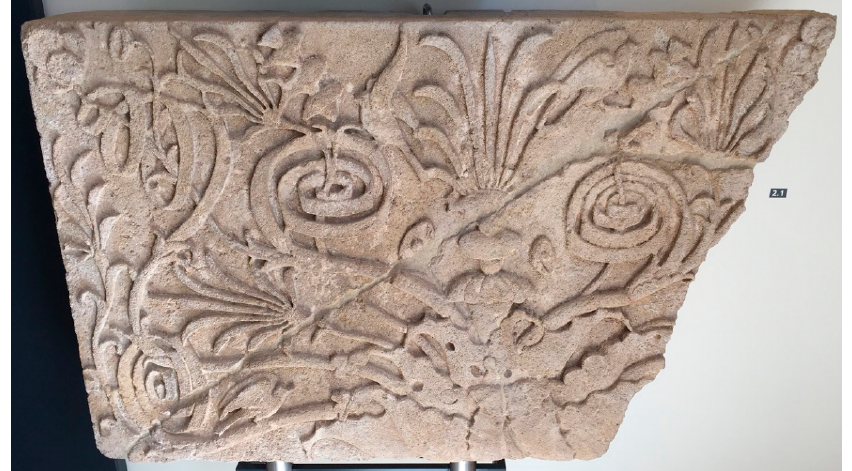
Figure 19. Taranto, Museo Archeologico Nazionale inv. 51388 Limestone funerary monument wall relief with acanthus calyx and flowering tendrils from Corso Piemonte in Taranto, late 4th—early